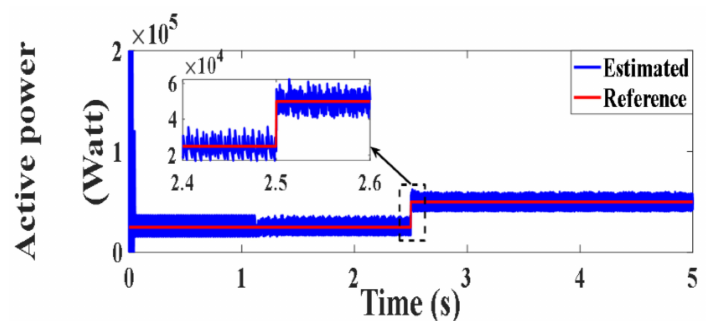
Figure 59. Active power under PVC